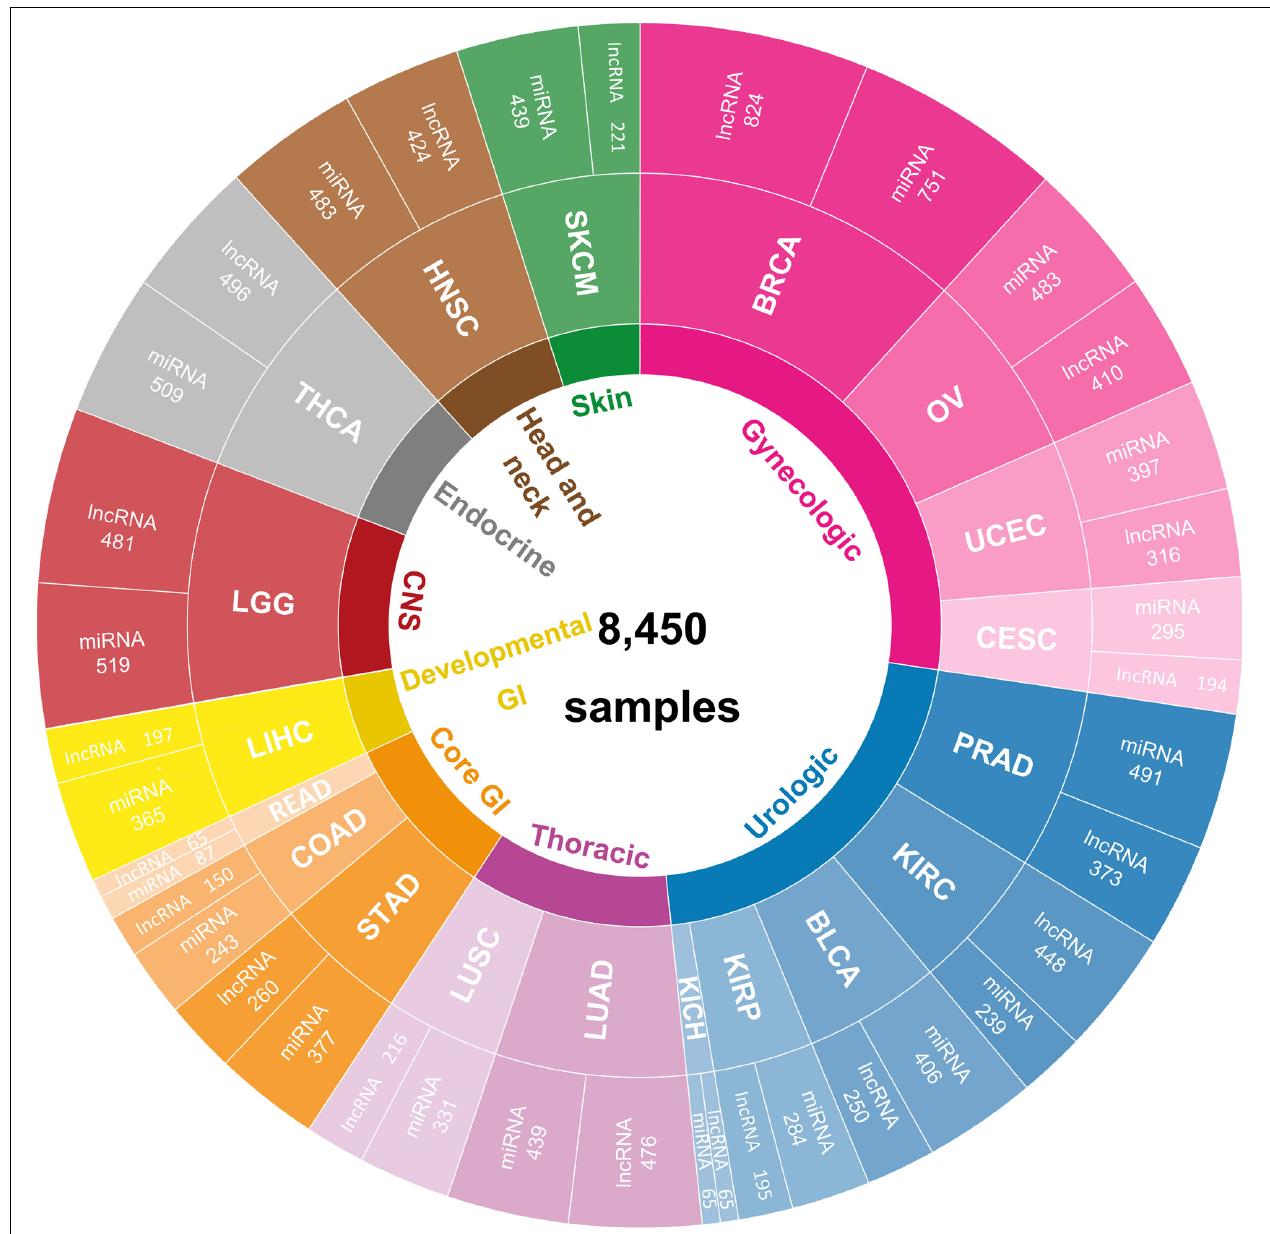
FIGURE 1 | The pan-cancer datasets collated in this study. Data distribution of corresponding ncRNA samples for 19 cancer types in nine cancer